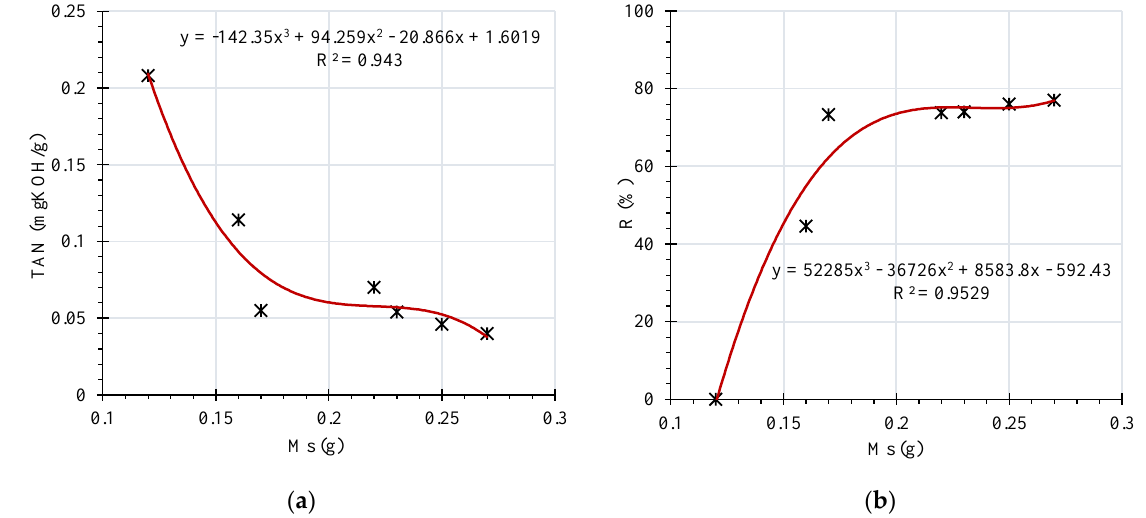
Figure 6. Illustration of the TAN and R of membrane as a function of mass of the RC membrane. ( a ) Variation of TAN of the filtrate with mass of RC membrane. ( b ) Variation of TR with the mass of RC sorption